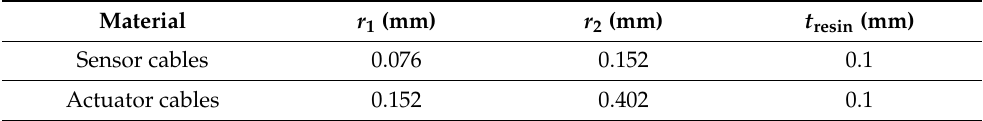
Figure 12. Composition and geometry of cable sections. Table 2. Geometric dimensions of the